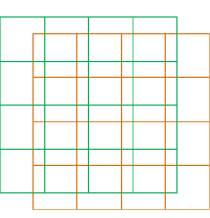
Figure 1. The footprint of a map sheet in UTM projection (green) and the bounding box needed to obtain rectangular images (blue). The choice of a sheet division that is not rectangular nor oriented to the north in the map projection causes problems afterwards.